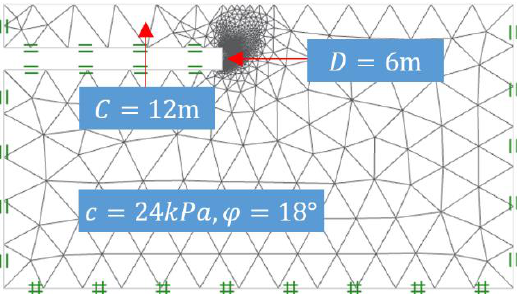
Figure 6. Strength reduction analysis for verification.